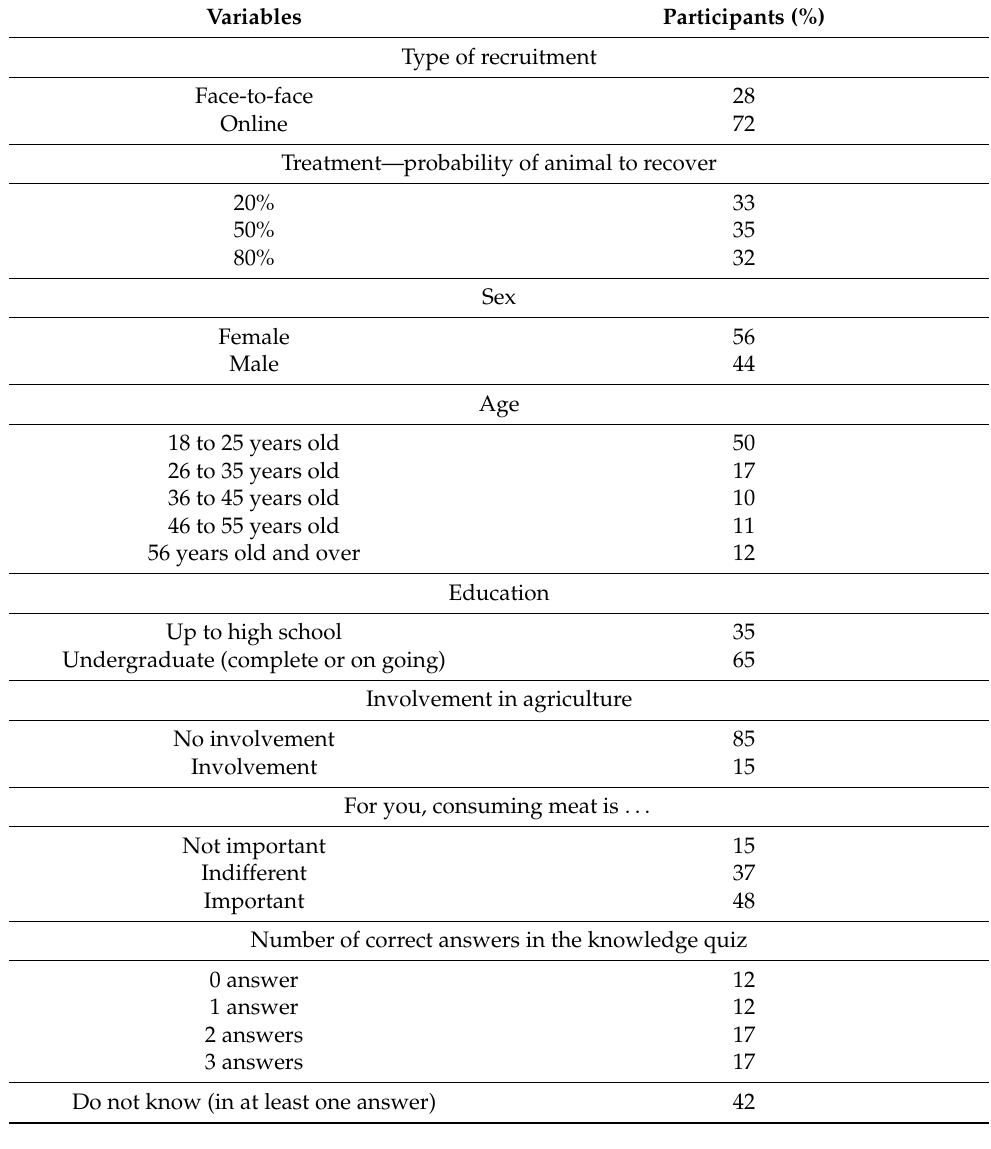
Table 1. Demographics of survey participants ( n = 1780).